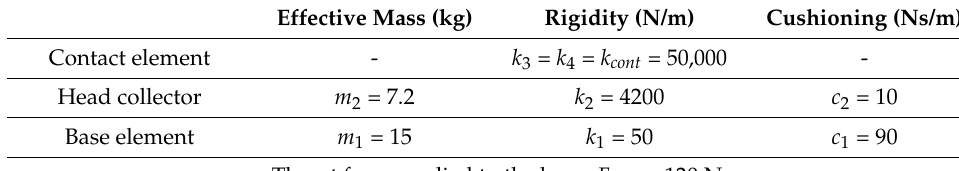
Figure 4. Pantograph models of punctual masses. Table 1. Pantograph parameters according to EN5038.